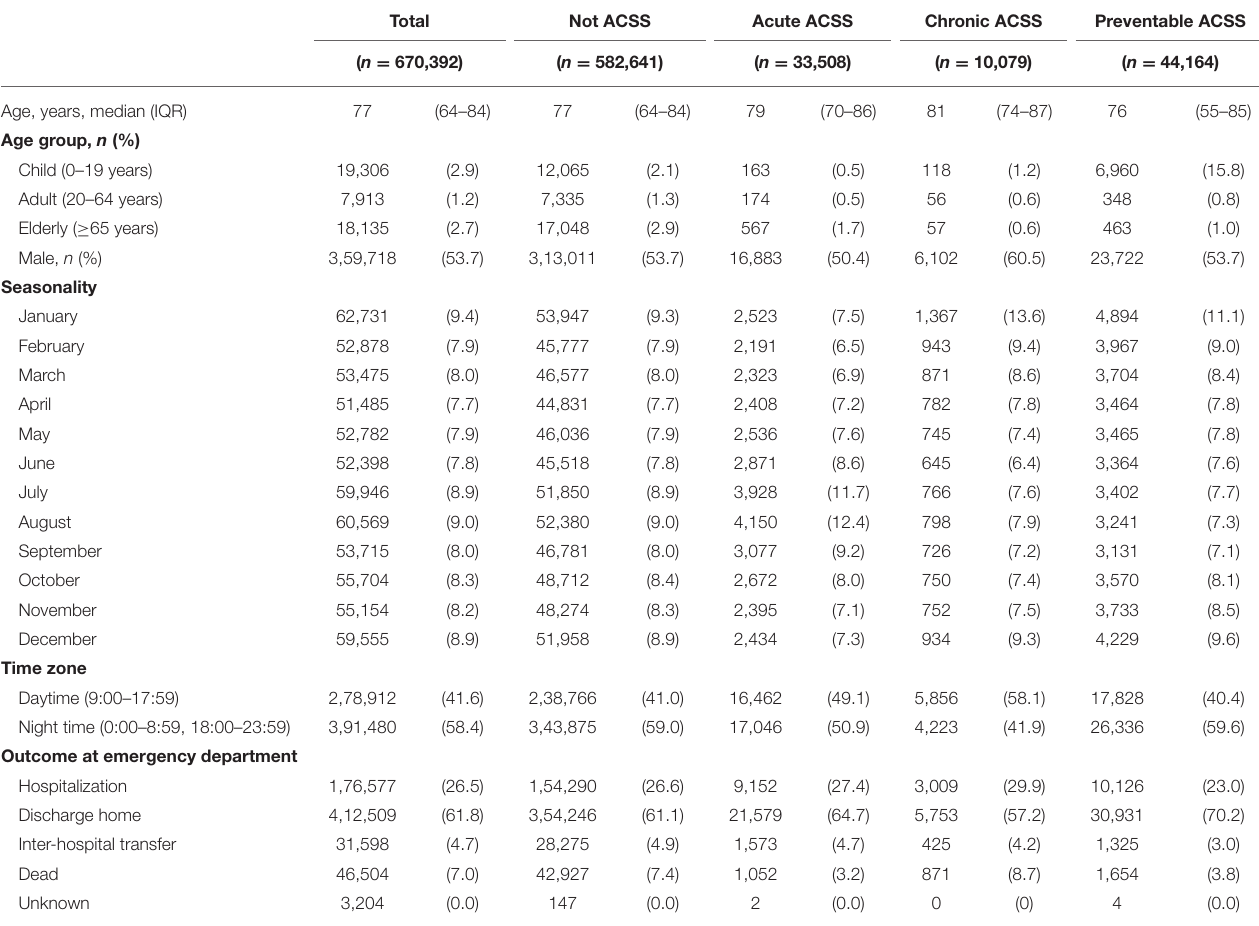
TABLE 2 | Unnecessary ambulance use with or without telephone triage